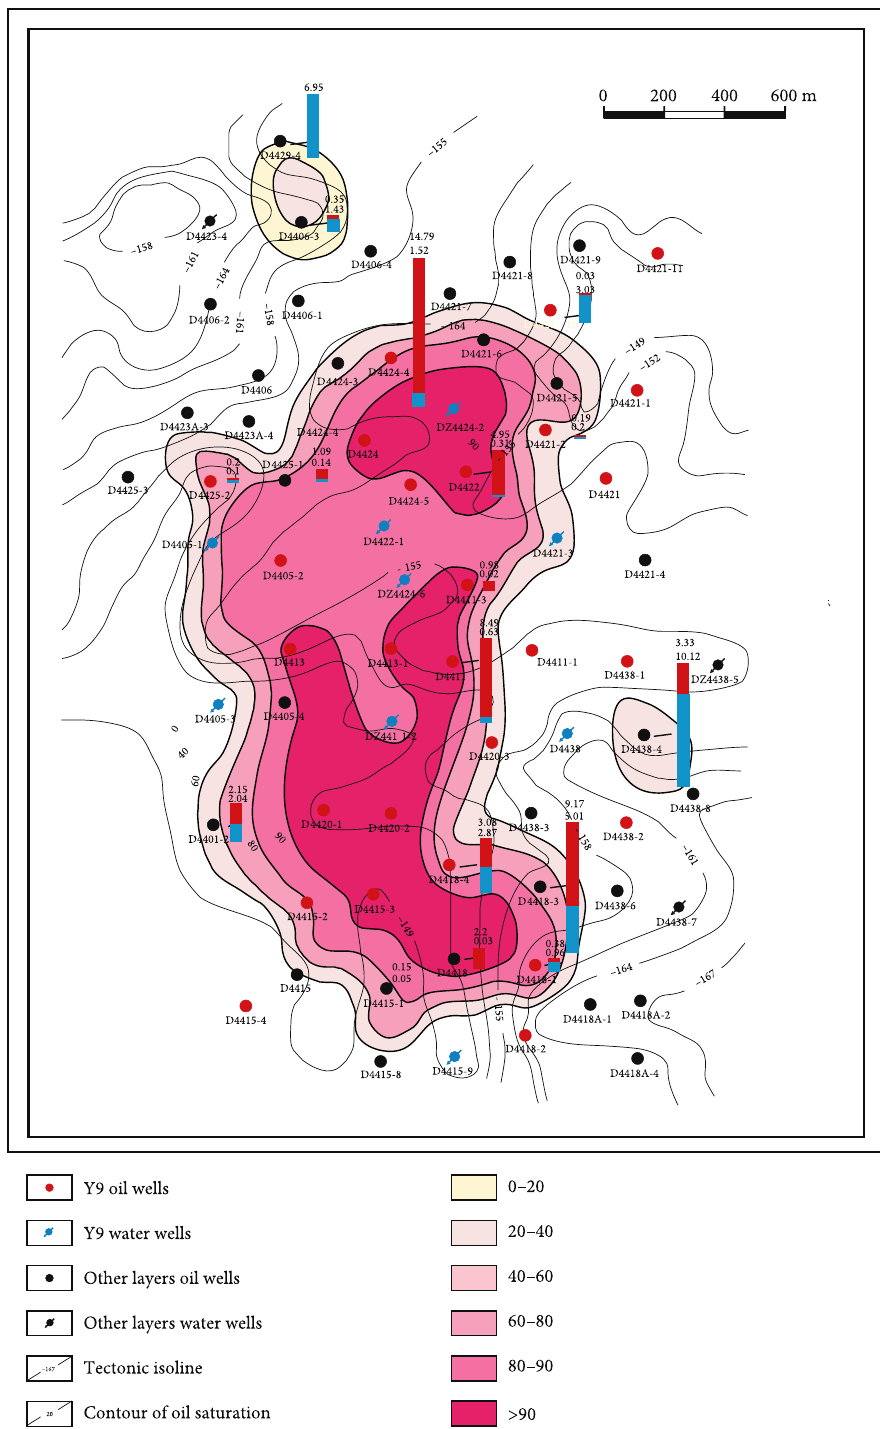
Figure 17: Superposition diagram of oil saturation and structure of Yan 9 32-1